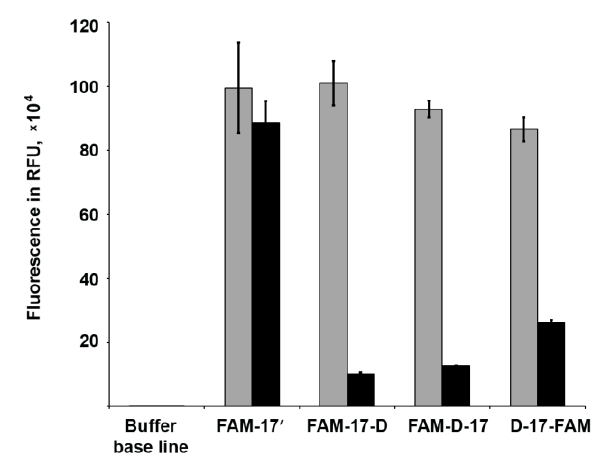
Figure 6. Fluorescence intensity values of 1.5 µM fluorescently labeled FAM-17’, FAM-17-D, FAM-D-17, and D-17-FAM oligomers in TAM (black columns) or TA (grey columns) buffer conditions. For excitation and emission scanning parameters, see 2.9. We hypothesized that during the FAM-D-17 self-assembly, FAM residues are encapsulated into the micelle core, thereby interacting with each other in close proximity and providing significant fluorescence quenching. For instance, fluorescence from Oregon green residues in dye-conjugated titin molecules quenched in the native folded state of the protein due to the proximity of dye residues [47].